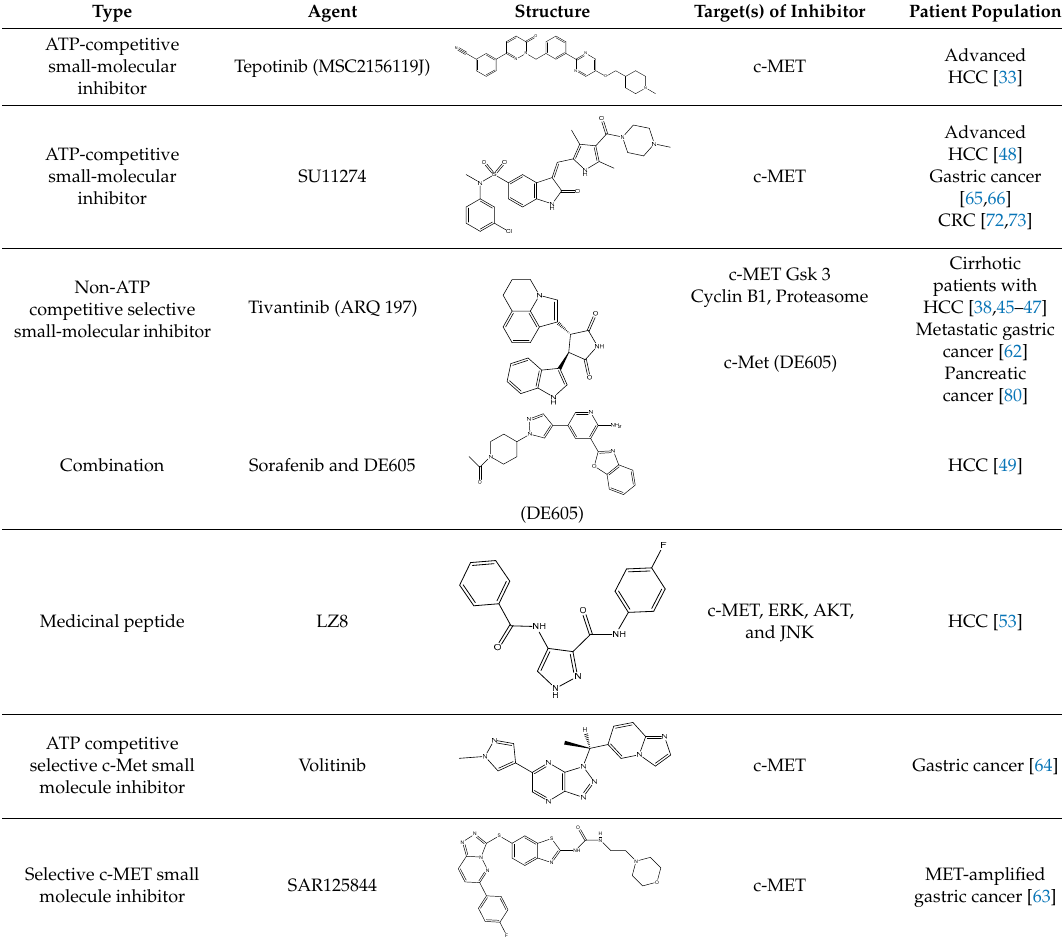
Table 1. Properties of c-MET inhibitors for digestive system cancer treatment.